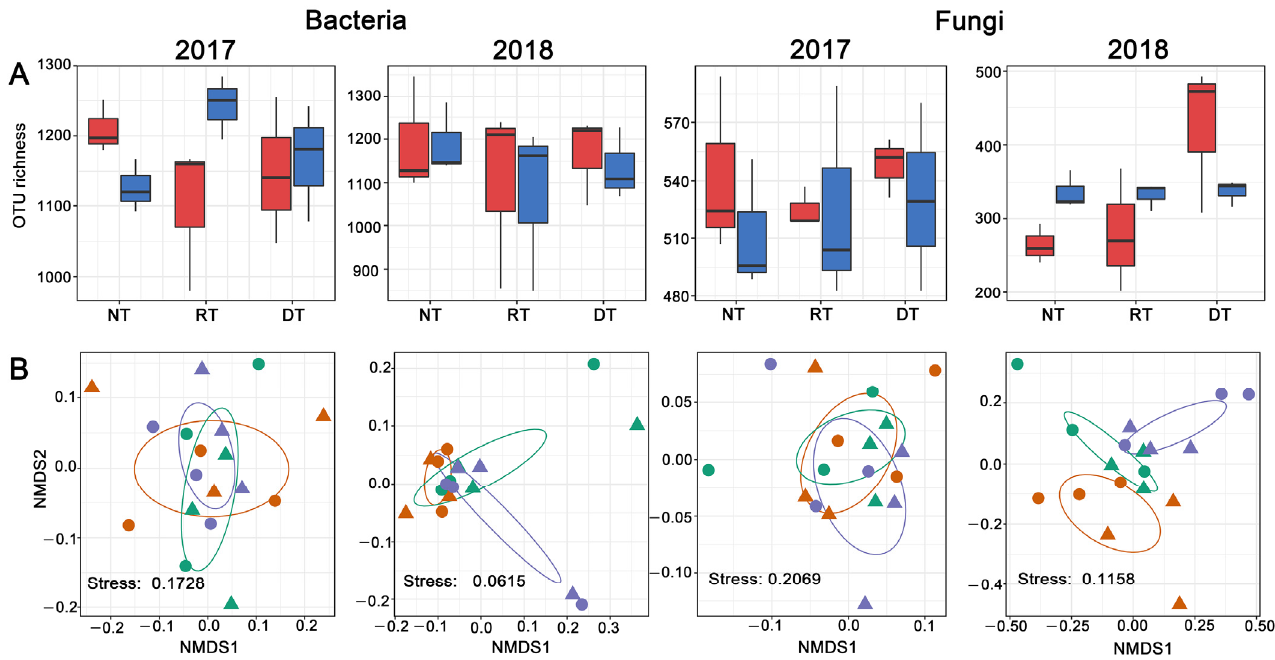
Figure 1. ( A ) Soil bacterial and fungal OTU richness among treatments, red: residue removal; blue, residue retention; ( B ) non-metric multidimensional scaling (NMDS) of bacterial and fungal community compositions among tillage systems. Circles with a solid line in the NMDS plot are 95% confidence ellipses; triangle: residue removal; circle, residue retention, purple, no tillage; orange, rotary tillage; green, deep tillage.